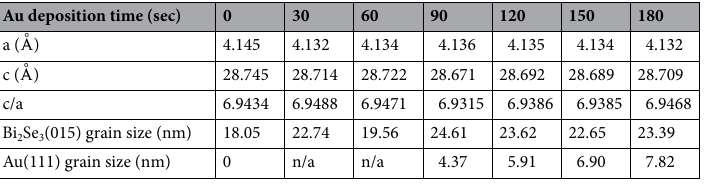
Table 2. Lattice constants (a and c) of Bi 2 Se 3 NPs, and grain sizes of Bi 2 Se 3 and Au in various Au deposition